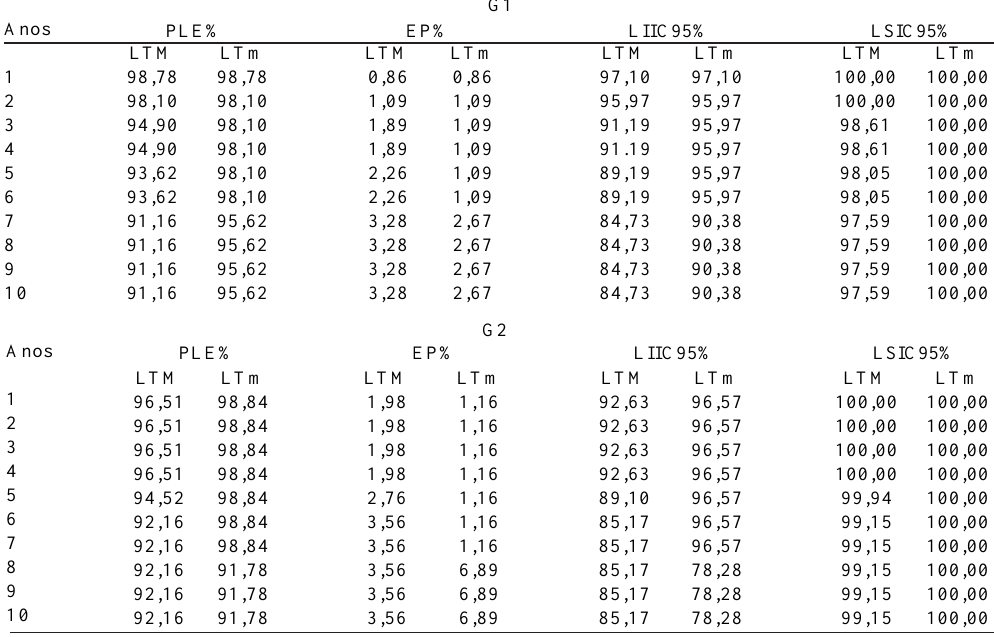
Tabela 2. Dados atuariais de acordo com os conjuntos de grupos (G1 e G2); Livres de qualquer evento - LQE, Livres de eventos tromboembólicos - LT e Livres de eventos hemorrágicos ou elevação exacerbada da RNI –